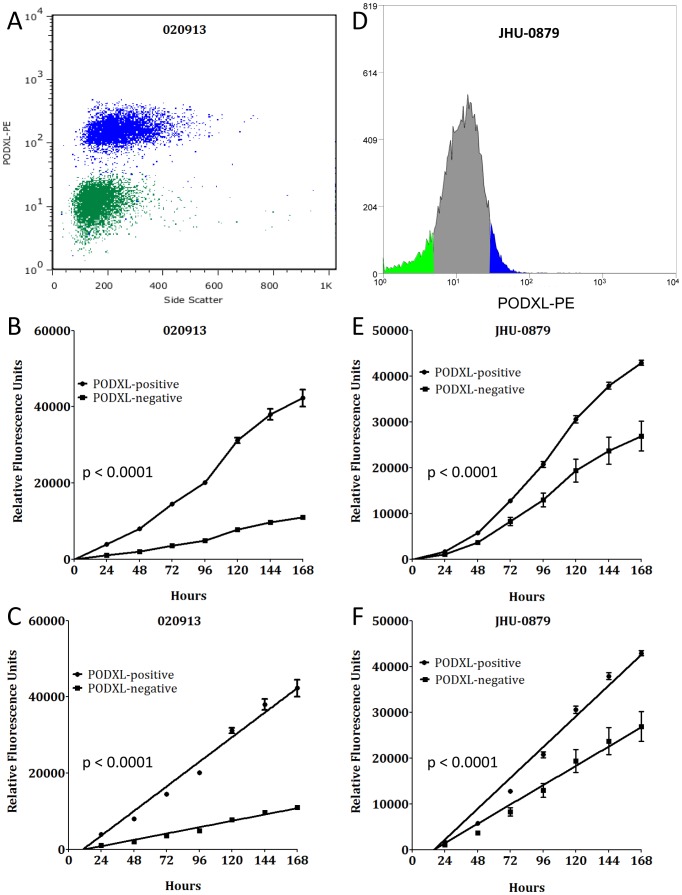
PODXL expression correlates with cell proliferation.(A): Representative post-sort analytical flow for PODXL-positive (blue) and PODXL-negative (green) populations in 020913 cells showing minimal overlap between the two populations. (B): Representative growth curves of the PODXL-positive and PODXL-negative populations from 020913 over 7 days and (C) the linear regression fit of the growth curve through day 7 (p<0.0001). Quantitatively similar results were obtained with each replicate. (D): Histogram of JHU-0879 FACS showing the gated PODXL-positive (blue) and PODXL-negative (green) populations. (E): Representative growth curves of the PODXL-positive and PODXL-negative populations from JHU-0879 over 7 days and (F) the linear regression fit of the growth curve through day 7 (p<0.0001). Quantitatively similar results were obtained with each replicate.